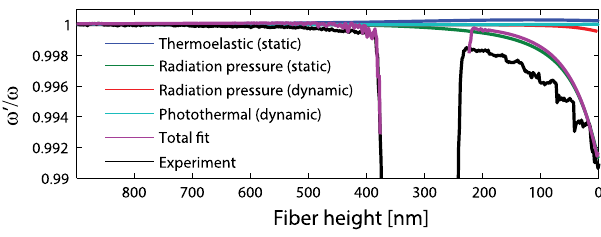
ð h Þ generated using the model in FIG. 13. Predicted ω 0 m Eq. (G10) and the parameters in Table